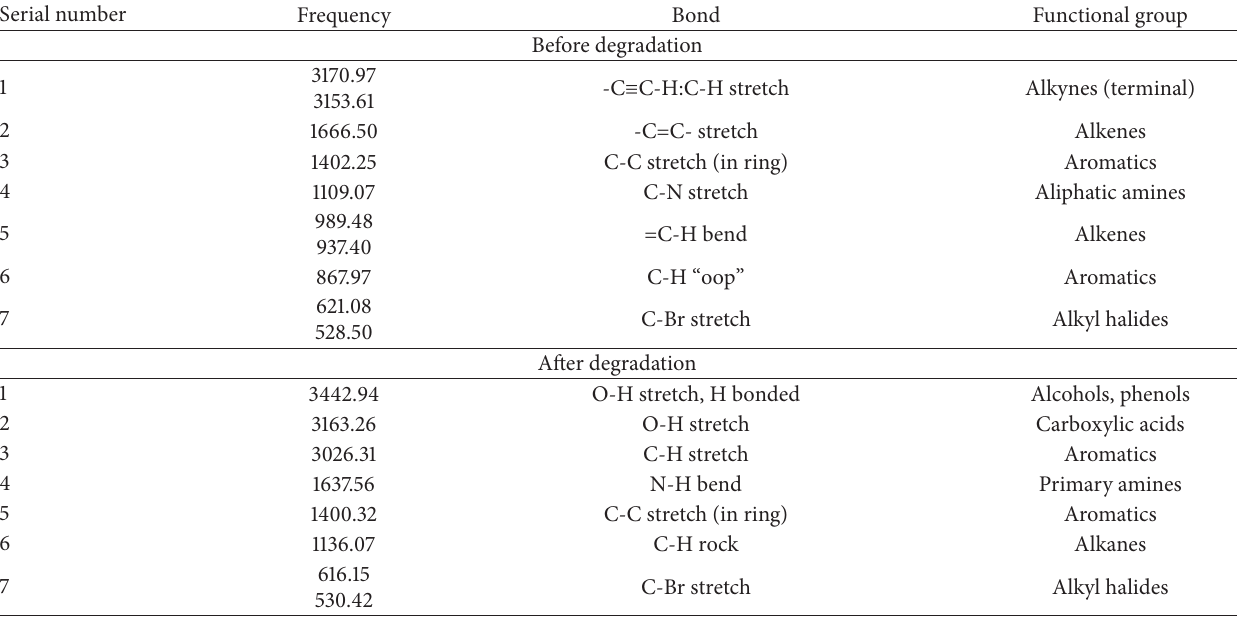
Table 4: Table showing frequencies visible in the spectra and their possible functional groups before and after degradation of